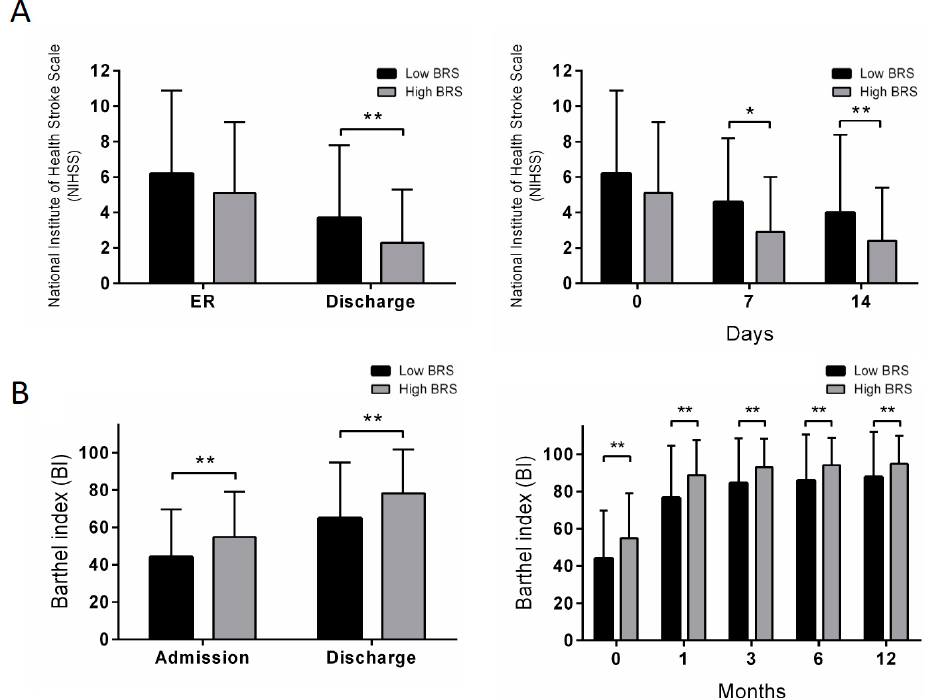
Figure 2. Neurologic severity and functional outcome in low-BRS and high-BRS groups at different